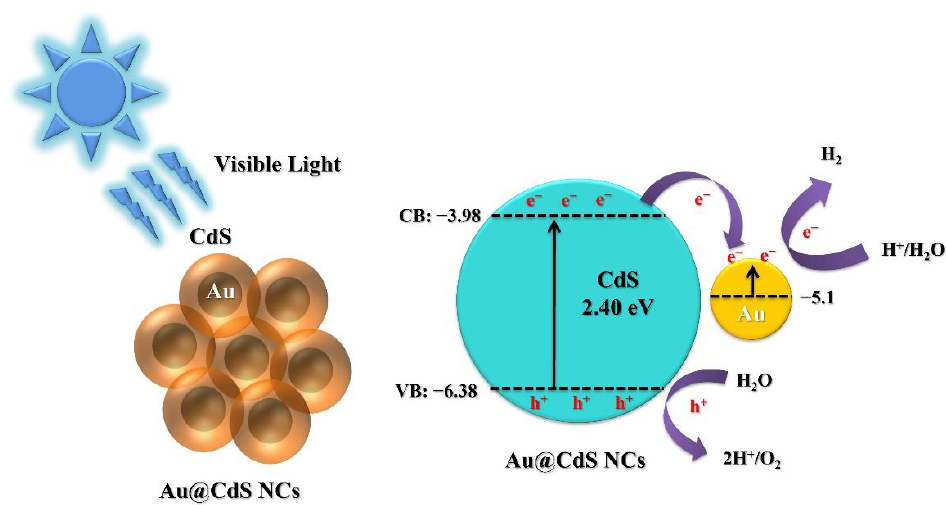
Figure 8. The schematic diagram illustrates the photocatalytic mechanism of Au@CdS nanocompo-